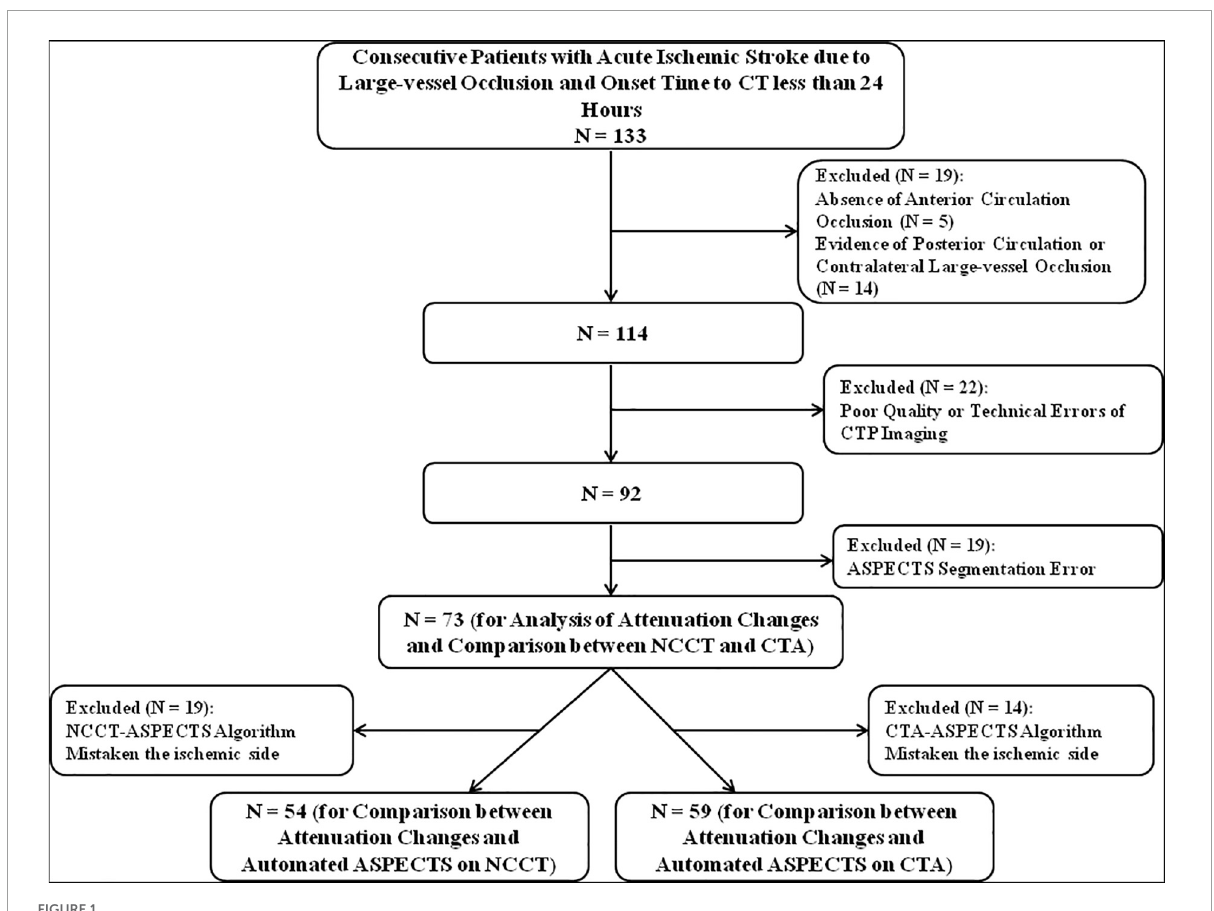
FIGURE1 Patient inclusion